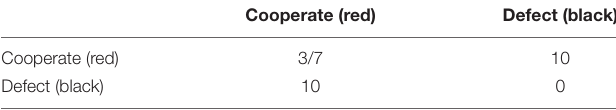
TABLE 1 | The modified prisoner’s dilemma game matrix in the present study. Cooperate (red) Defect (black) Cooperate (red) 3/7 10 Defect (black) 10 0